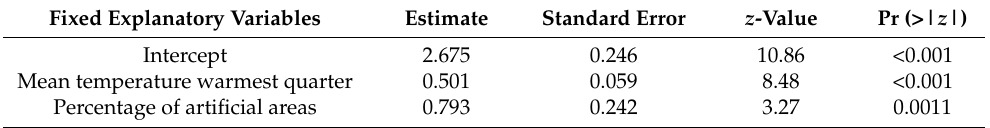
Table 2. Estimated coefficients and statistics of the most parsimonious negative binomial mixed model selected for simulating the seasonal abundance of Aedes albopictus females (i.e., sum of females collected in eight trap nights between June and September).